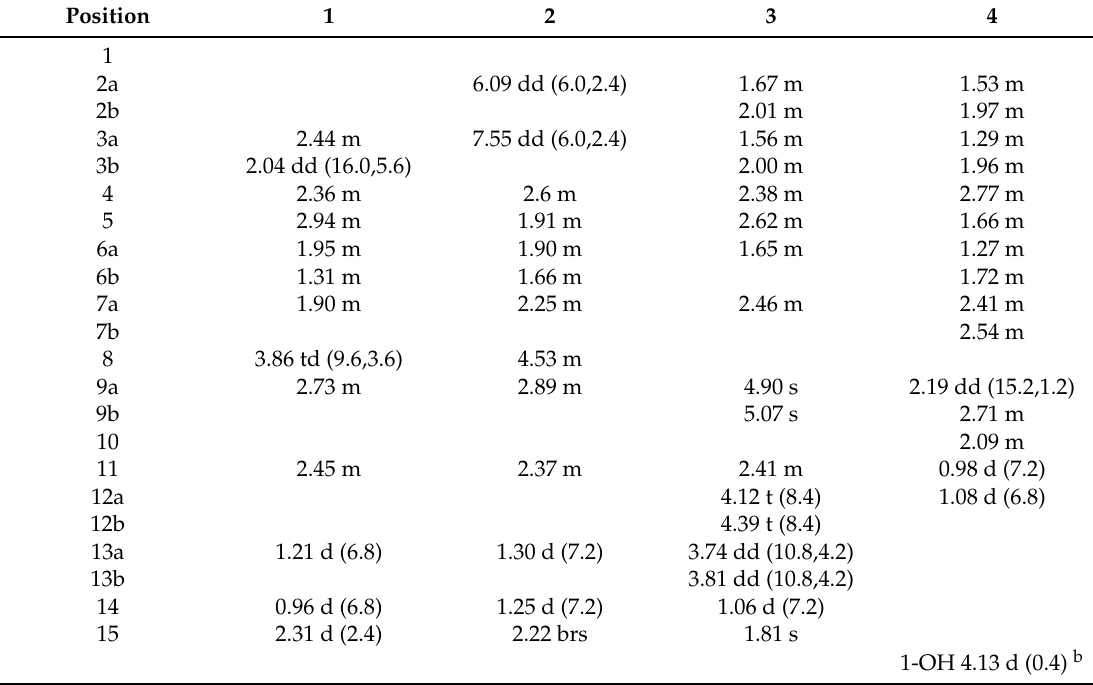
Table 1. 1 H-NMR spectroscopic data of compounds 1 – 4 ( J in Hz) a .